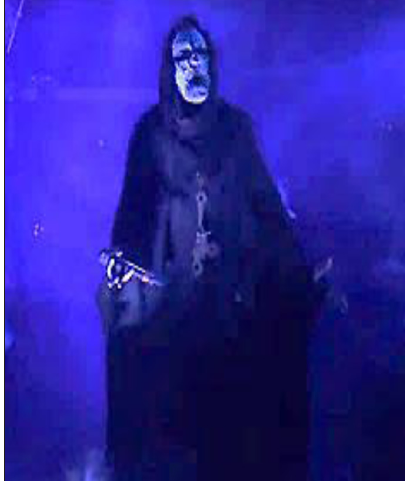
Figure 4: Attila Csihar, performing “Freezing Moon” in December 2015 (official Mayhem on